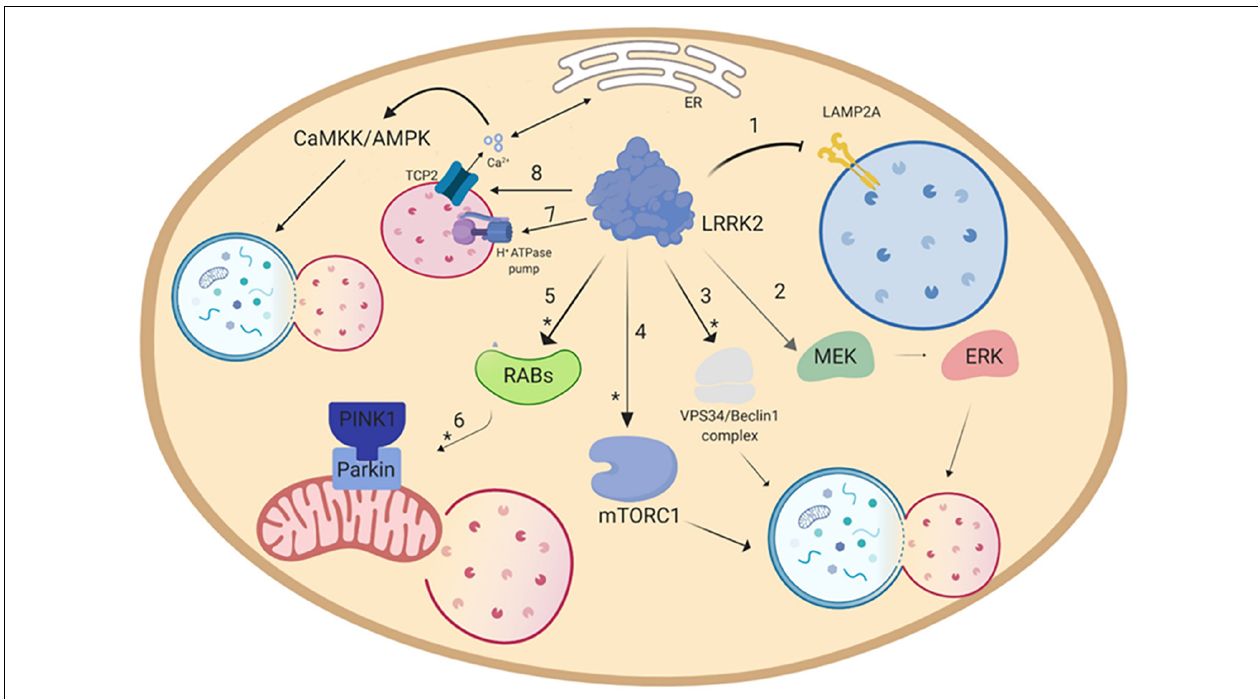
FIGURE 2 | Putative pathways through which LRRK2 modulates autophagy. (1) Overexpression of LRRK2 or its mutants inhibits CMA through blockade of the translocation into the lysosome operated by the LAMP2A receptor (Orenstein et al., 2013). Furthermore, LRRK2 is able to modulate autophagy by activating either (2) the MEK/ERK (Bravo-San Pedro et al., 2013), or the (3) VPS34/Beclin1 complex (Manzoni et al., 2016). Other putative pathways are (4) the mTORC1 pathway (Imai et al., 2008; Ho et al., 2018), or (8) the Ca 2 + /CaMKK/AMPK pathway (Gomez-Suaga et al., 2012b). As for mitophagy (5) , LRRK2, via Rab activation (Wauters et al., 2019), is able to disrupt the (6) PINK1/Parkin-mediated mitophagy (Saez-Atienzar et al., 2014; Schapansky et al., 2014; Yakhine-Diop et al., 2014; Bonello et al., 2019). Furthermore, LRRK2 can regulate lysosomal pH via (7) lysosomal H + -ATPase pump (Wallings et al., 2019). Asterisk ( ∗ ) indicates the putative pathways modulated by pharmacological LRRK2 kinase